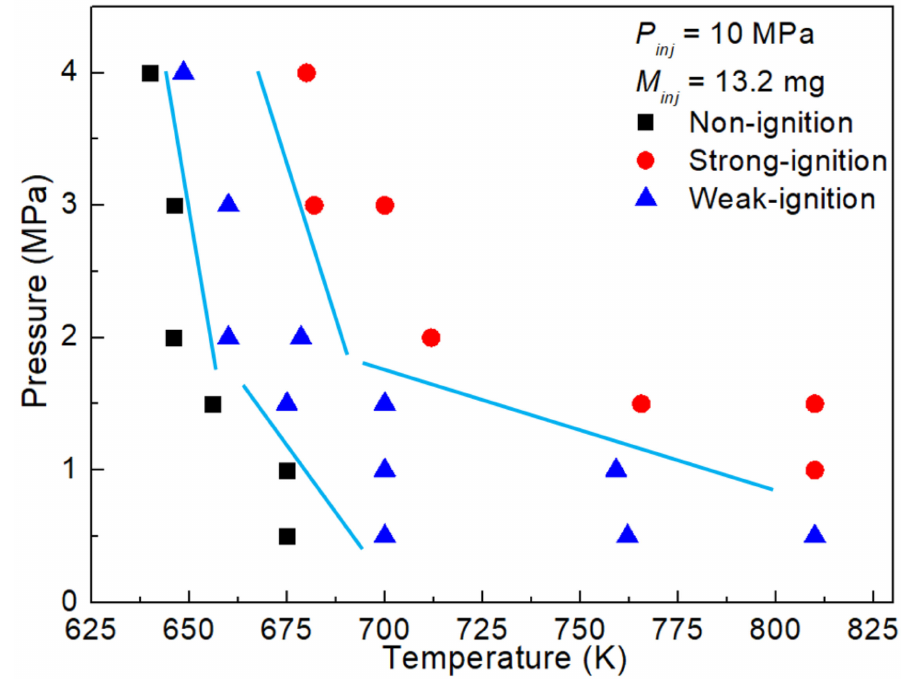
Figure 11. Ignition performance of RP-3 kerosene under a wide temperature and pressure